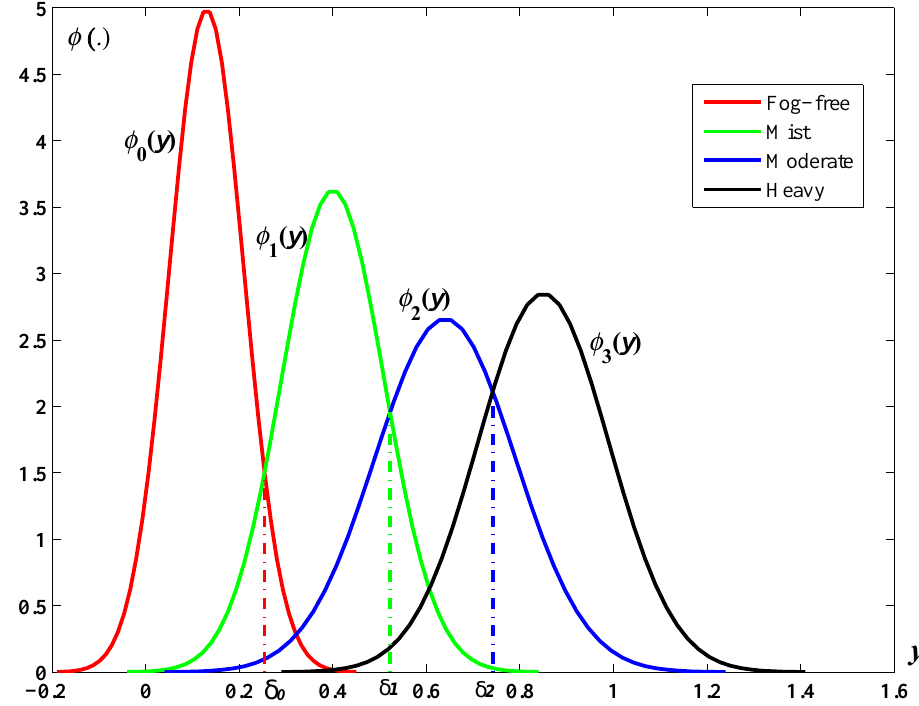
Figure 2. Estimation of parameters using the intersection points of the adjacent normal distribu- tion